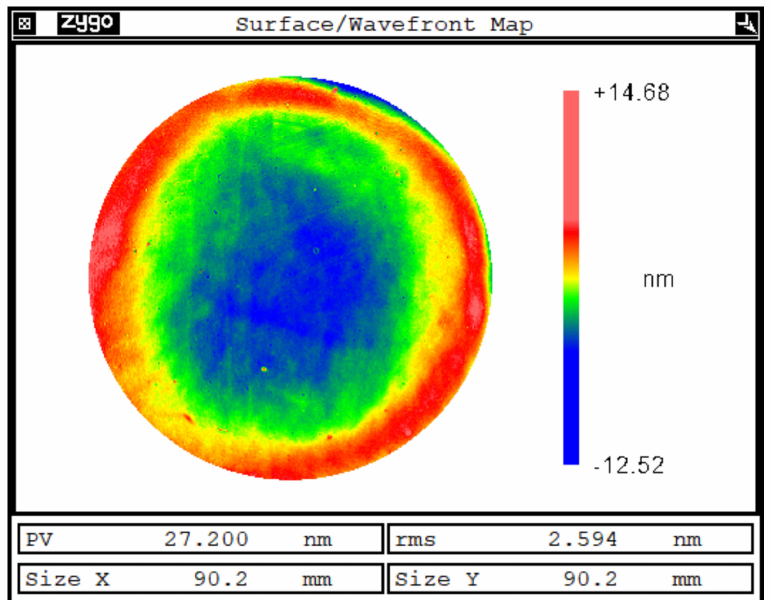
Figure 16. The initial surface figure of the given